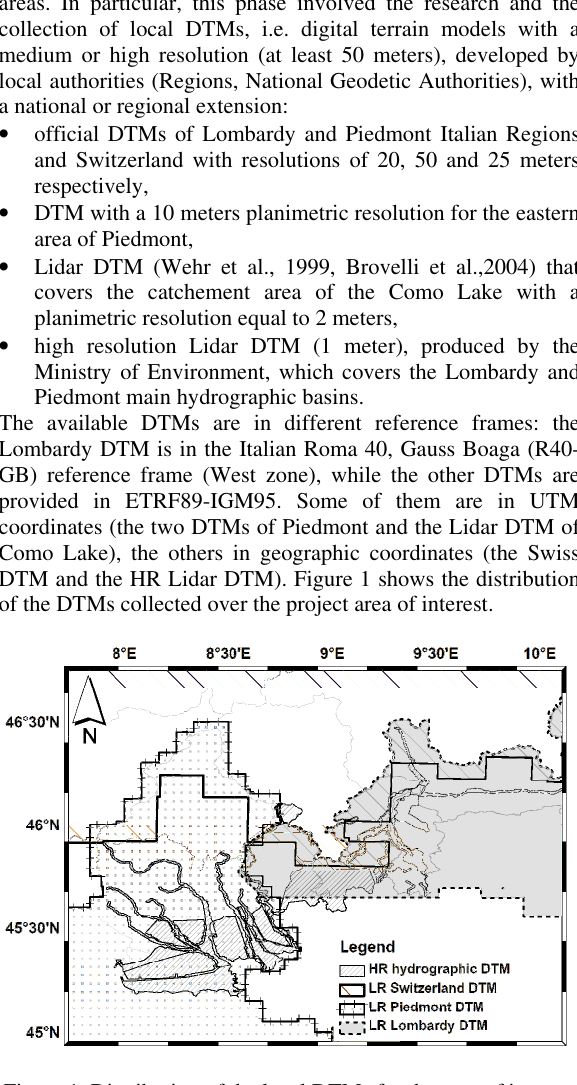
Figure 1. Distribution of the local DTMs for the area of interest